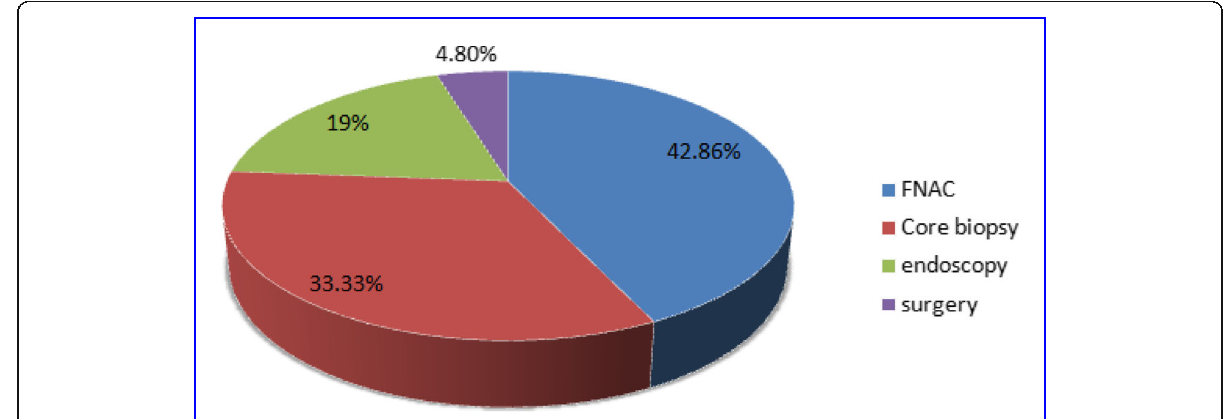
Fig. 2 Types of biopsy (diagnostic procedure) of extra malignancy in the studied group (pie-chart)